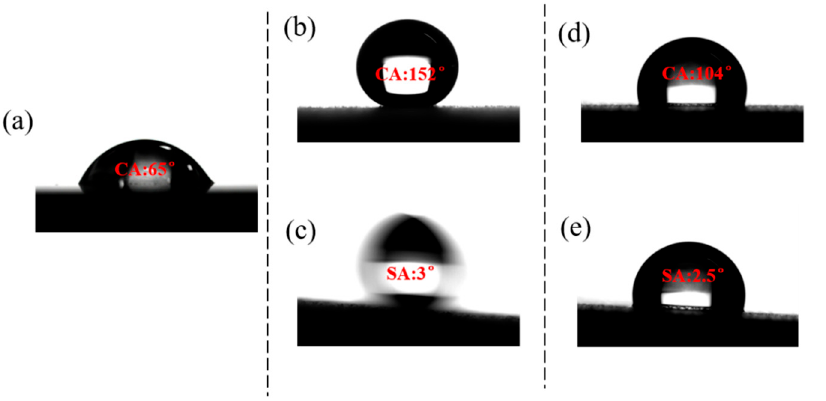
Figure 4. Wettability of the aluminum alloy: ( a ) CA of Untreated sample; ( b,c ) CA and SA of SHS sample, respectively; ( d ) CA and ( e ) SA of SLIPS sample, respectively.